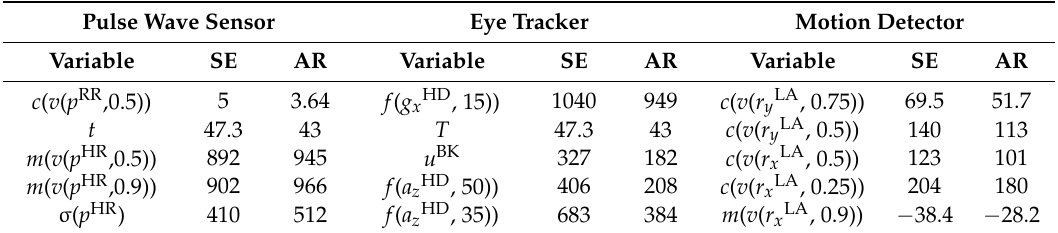
Table 9. Top five of the important variables for predicting the arousal in the personalized model. Pulse Wave Sensor